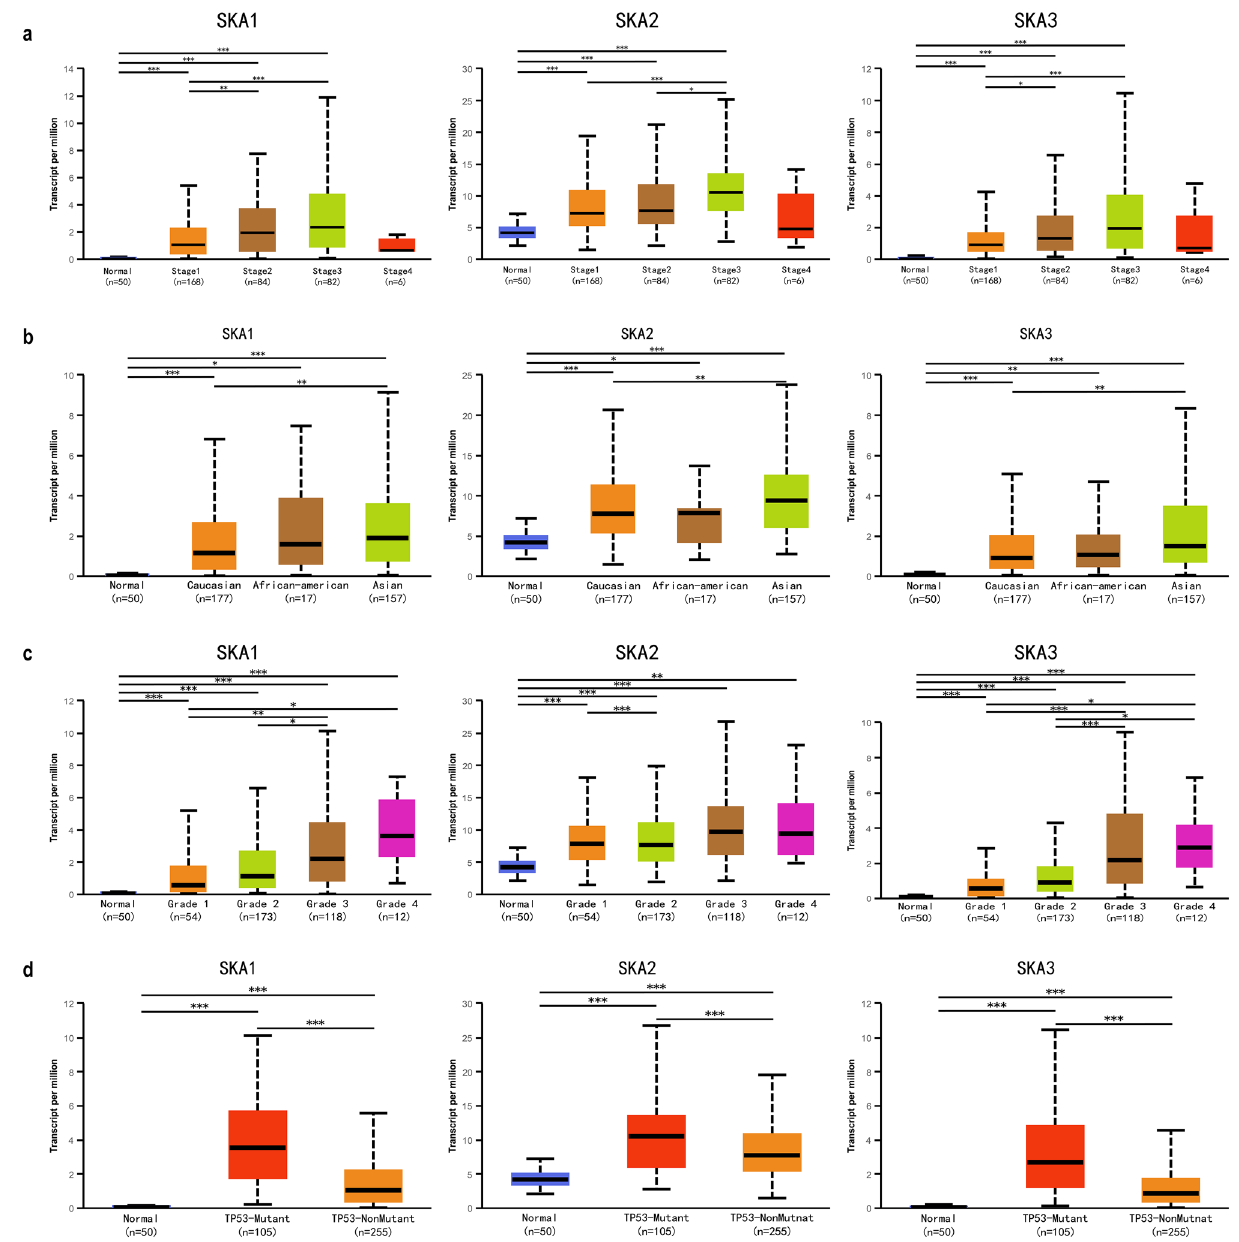
Figure 3. Correlation between mRNA expression levels of SKAs and clinicopathological parameters of HCC patients. (UALCAN). ( a ) Correlation between mRNA expression levels of SKAs and tumor stages of HCC patients. ( b ) Correlation between mRNA expression levels of SKAs and race of HCC patients. ( c ) Correlation between mRNA expression levels of SKAs and tumor grade of HCC patients. ( d ) Correlation between mRNA expression levels of SKAs and TP53 mutation status of HCC patients. * P < 0.05, ** P < 0.01, ** P <